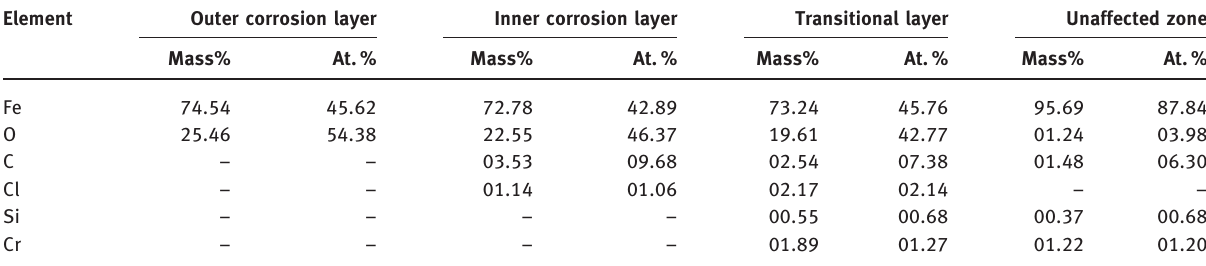
Table 6: Composition of cross-sectional layers on the corrosive specimen (998.15K/100MPa). Element Outer corrosion layer Inner corrosion layer Transitional layer Unaffected